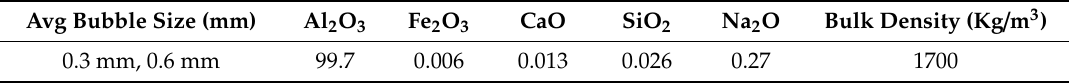
Table 1. Chemical composition of the hollow aluminum oxide.